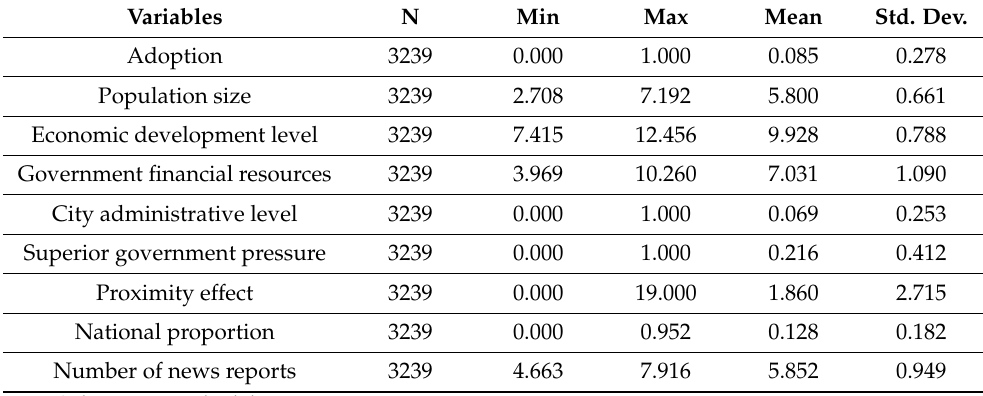
Table 2. Descriptive statistics.